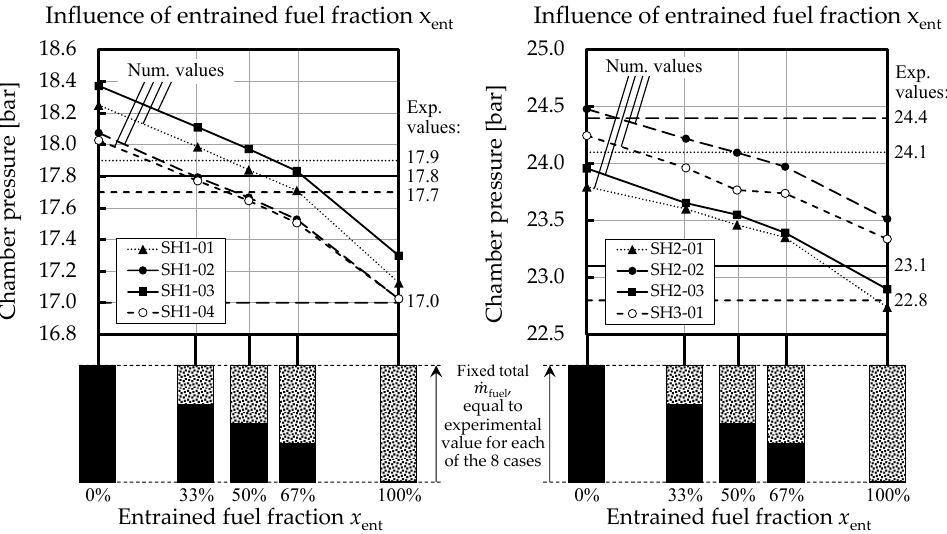
Figure 20. Impact of entrained fuel fraction x ent on P ch ,num for the simulations of 8 experiments, while keeping the total fuel mass flow rate